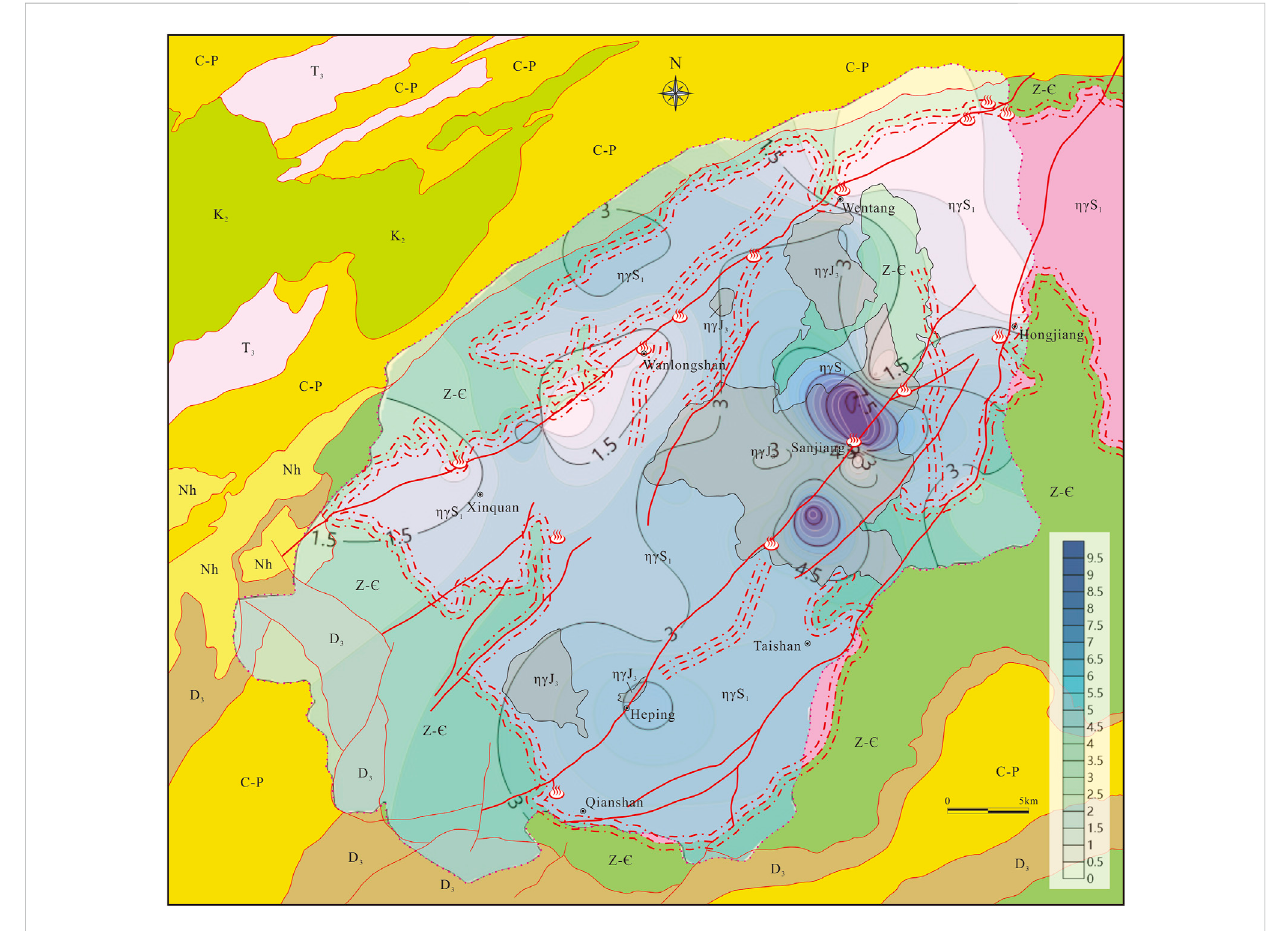
FIGURE 12 Relationship between δ 18 O and δ D in water samples in the Wugongshan